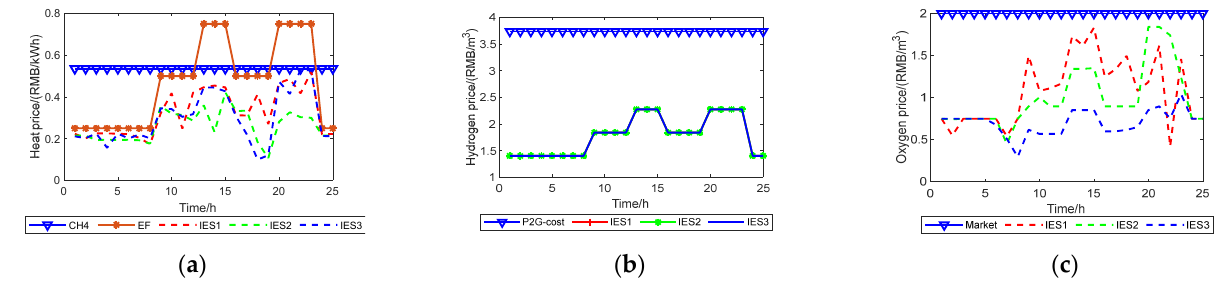
Figure 8. IES cluster energy supply and market prices. ( a ) Heat price. ( b ) hydrogen price. ( c ) Oxygen price. Table 11. Energy supply